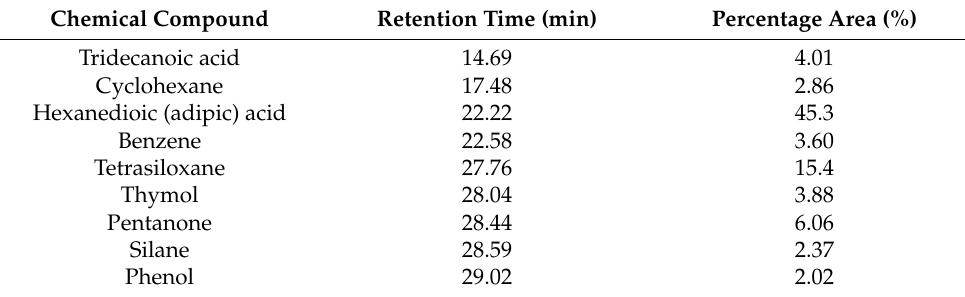
Table 1. Results from the GC-MS analysis of the methanolic extract of G. kola .